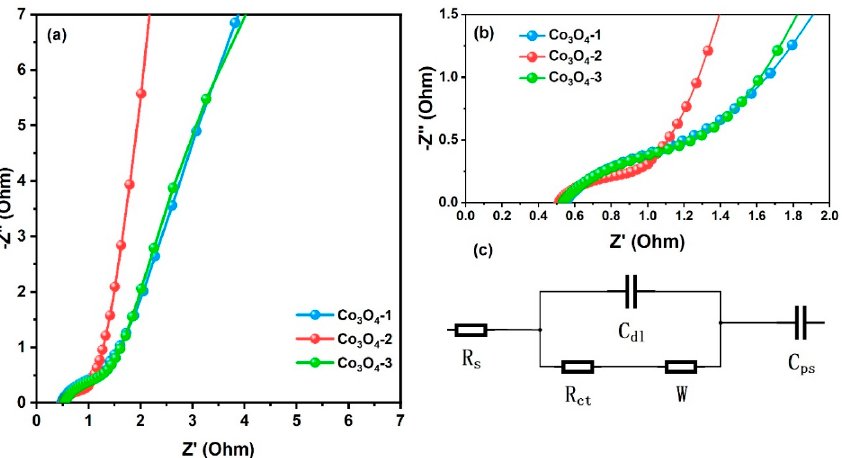
Figure 6. ( a ) Electrochemical impedance spectroscopy (EIS) plots of Co 3 O 4 -1, Co 3 O 4 -2 and Co 3 O 4 -3 electrodes; ( b ) enlarged view of high frequency region; ( c ) equivalent circuit involves intrinsic resistance and interface resistance ( R s ), double-layer capacitance ( C dl ), charge-transfer resistance ( R ct ), Warburg element ( W ) and pseudocapacitance ( C ps ).